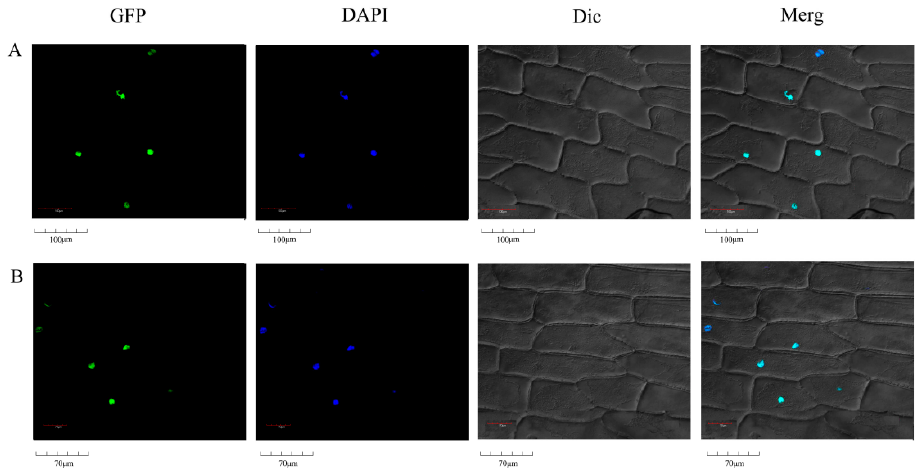
Figure 6. Subcellular localization of PbrSAUR13 -GFP and PbrSAUR52-GFP fusion protein. ( A ) Subcellular localization of PbrSAUR13 -GFP fusion protein; ( B ) Subcellular localization of P brSAUR52 -GFP fusion protein.